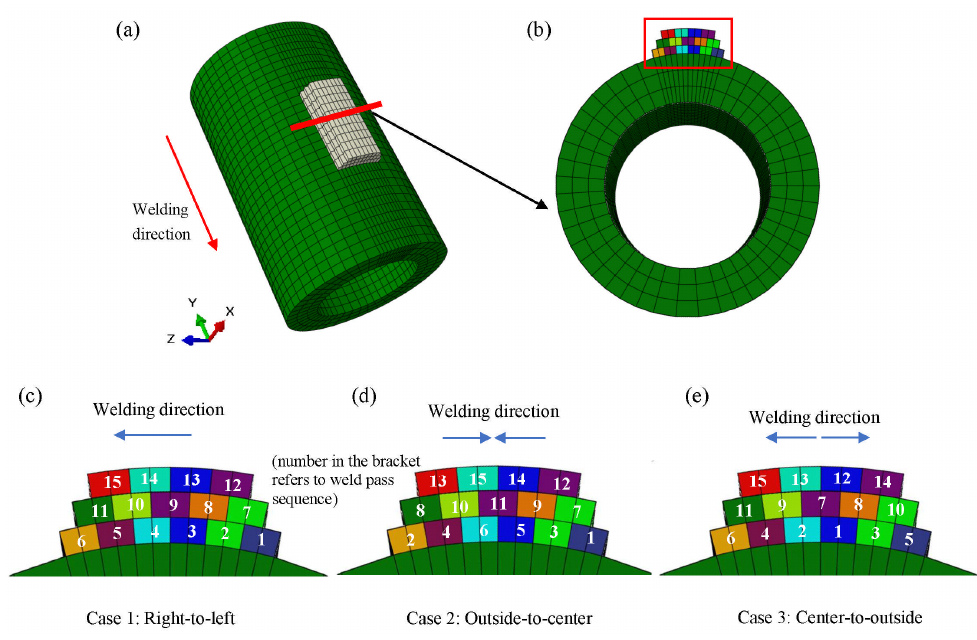
Figure 6. ( a ) Location of the transverse cross section on the tube, ( b ) transverse cross section at mid-length of the weld overlay joint and schematic diagram of the weld overlay with 3 different welding sequences: ( c ) case 1: right-to-left, ( d ) case 2: outside-to-center, and ( e ) case 3: center-to-outside.